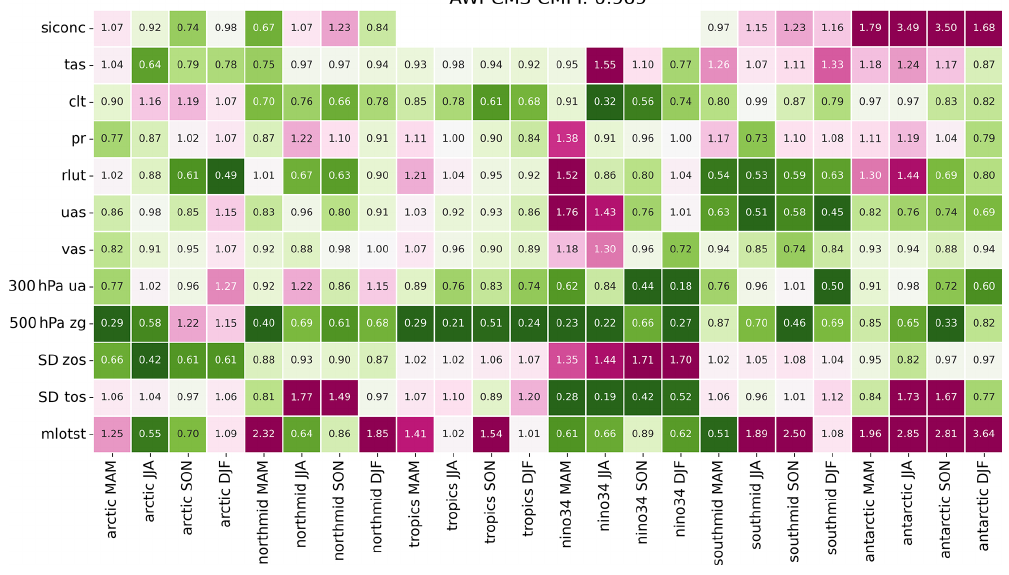
Table B2. TCo319L137-DART biases as in Table 4 but using NCEP/DOE Reanalysis II by Kistler et al. (2001) instead of ERA5 for